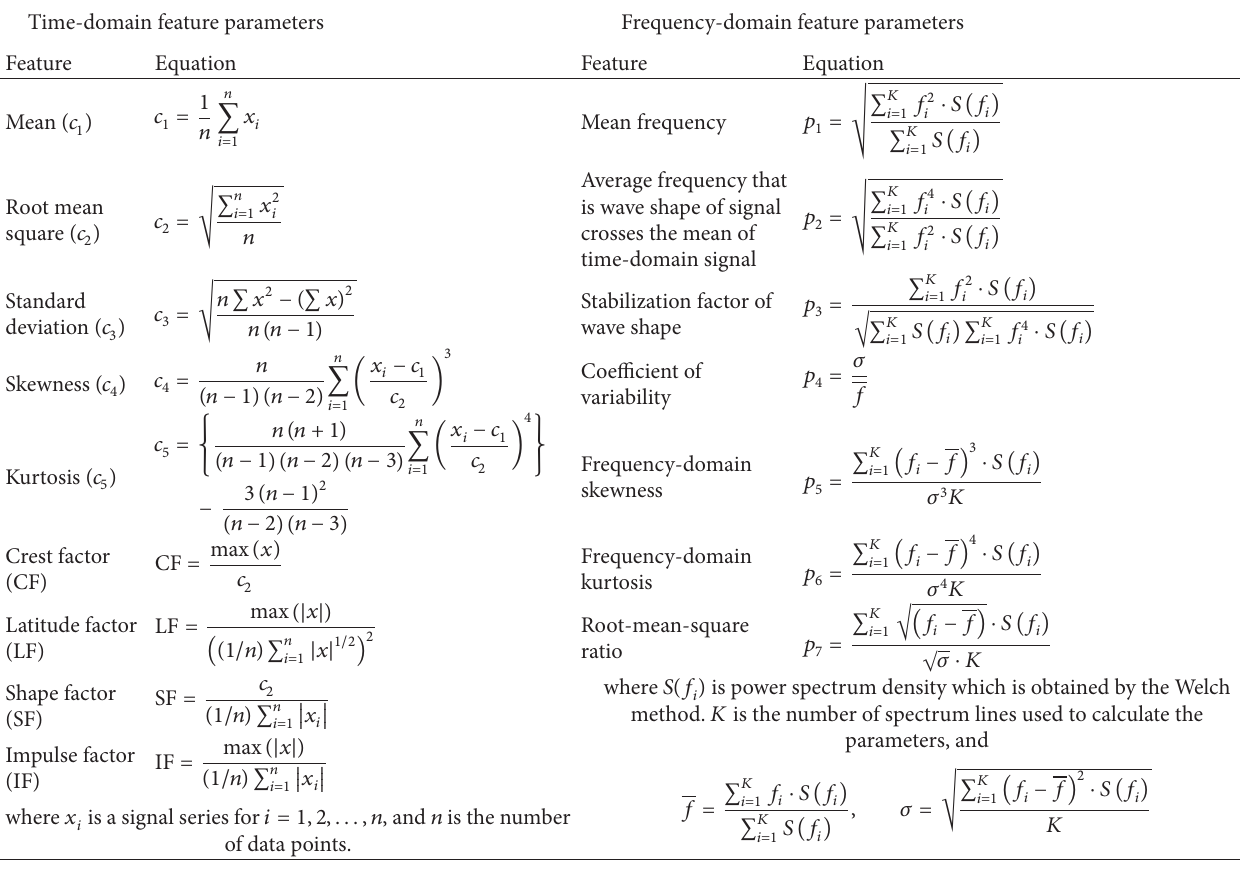
Table 1: Time-domain and frequency-domain feature